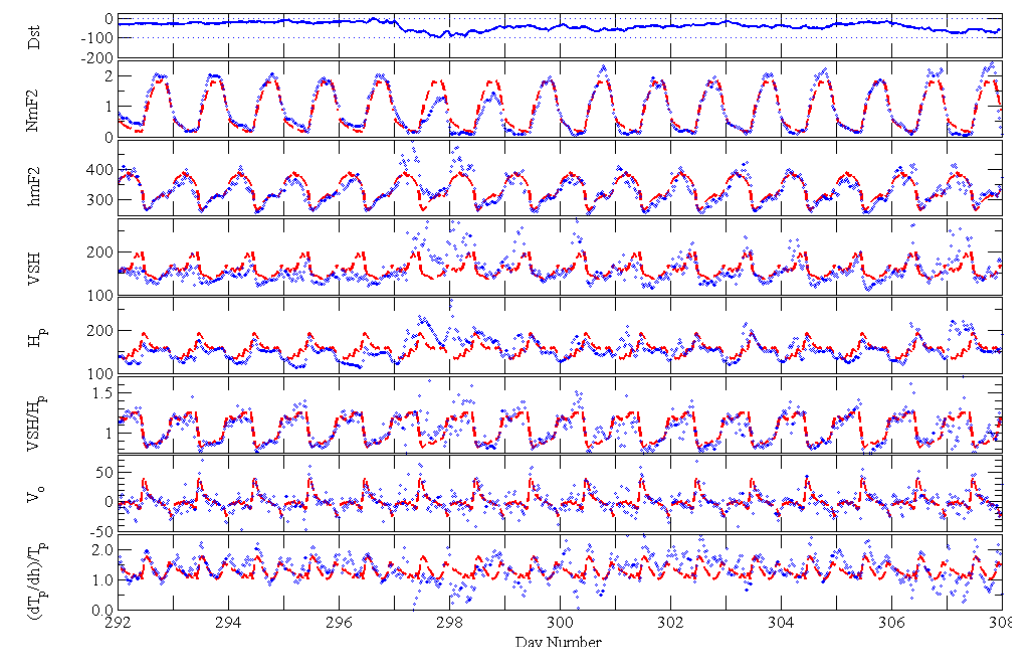
Fig. 6. Same as Fig. 5, but for 21 October to 5 November